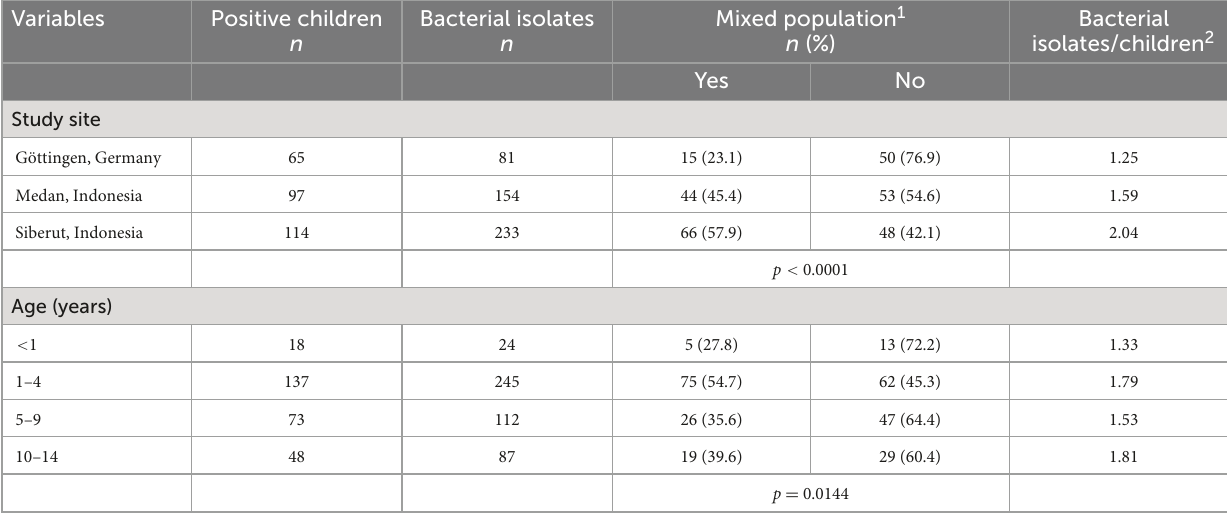
TABLE 5 Prevalence of hand-contaminating mixed bacterial populations and their association with sociodemographic factors.